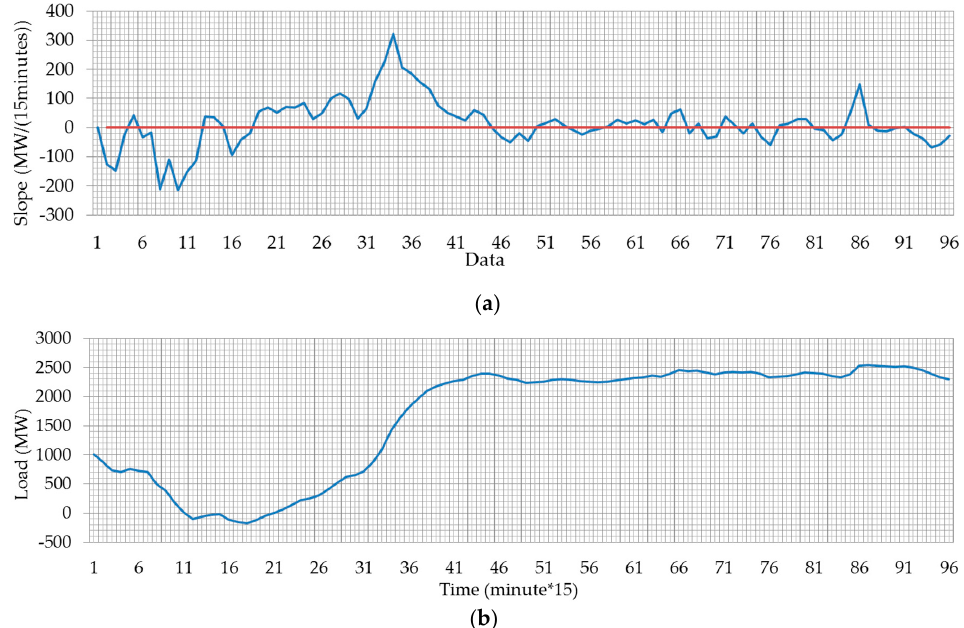
Figure 5. Net load curve and the adjacent point slope of 3 March, ( a ) The consecutive point slope; ( b ) The net load curve.